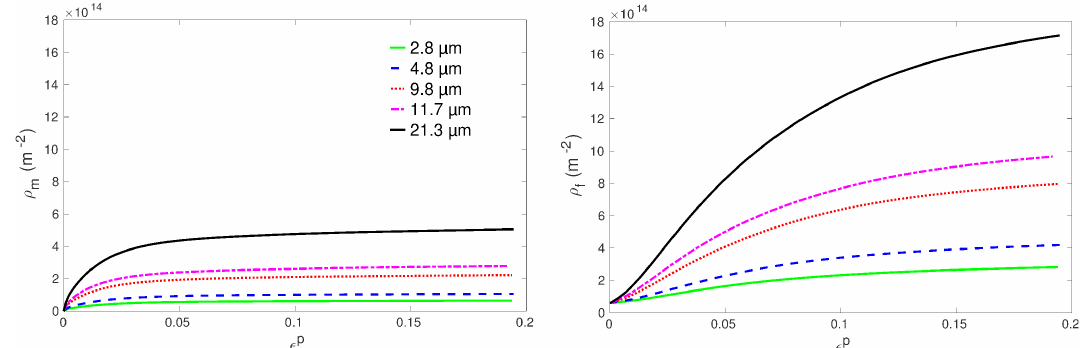
Figure 11. Model predictions for the evolution of the total forest ( ρ f ) and mobile ( ρ m ) dislocation densities for the specimens of RR type. Densities are cumulated over the 30 slip systems and averaged over the grains’